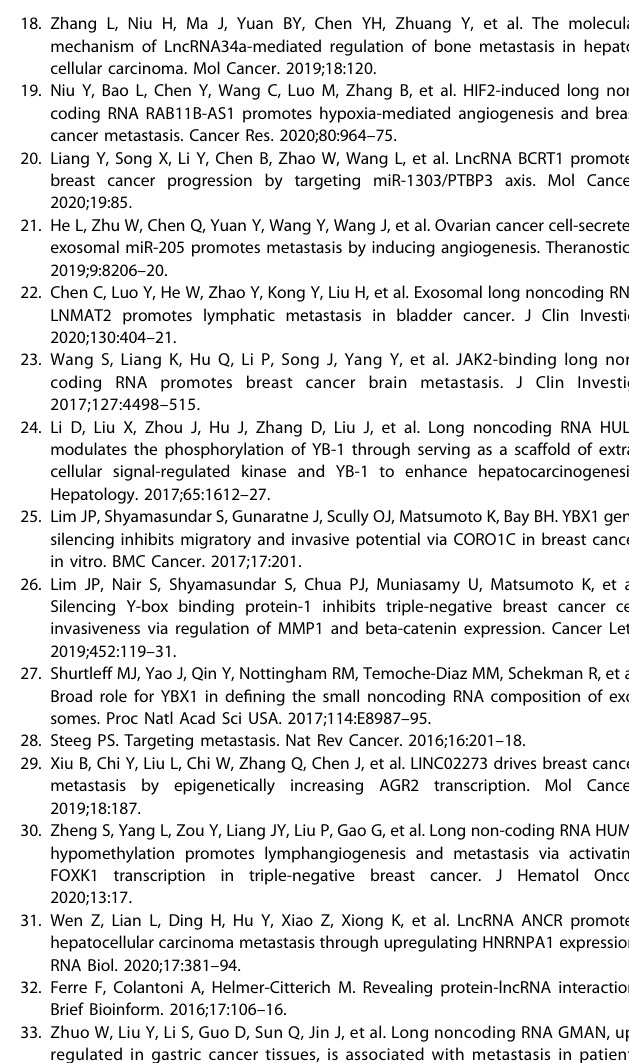
Fig. 8 A schematic diagram of the proposed mechanisms. A schematic illustration for the mechanisms by which AC073352.1 interacts with YBX1 to promote BC metastasis and how extracellular AC073352.1 from breast cancer cells was packaged into exosomes and induced HUVEC